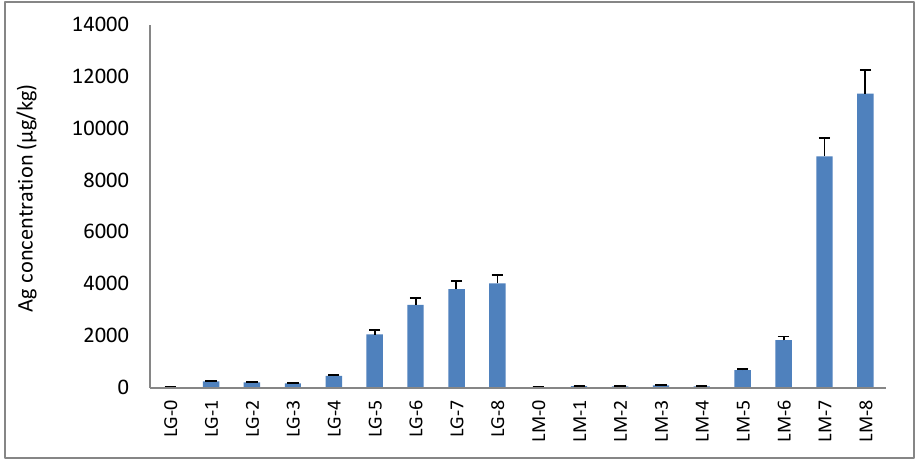
Figure 3. Ag accumulation ratios by L. gibba and L. minor . Despite the low concentrations of silver (9.25 µg L − 1 ) in the acid mineral water used in the study, L. gibba and L. minor were able to remove Ag from 433 L and 1222 L of acid mine water, respectively, by the end of the 8-day experiment. During the first four days of the experiment, similar increases in Au accumulation were observed in both L. gibba and L. minor . From the fifth to the eighth day, both plants exhibited a linear and very high accumulation performance. According to the control samples, L. gibba accumulated 78 times (176 µg kg − 1 ) and 394 times more Au (884 µg kg − 1 ) from acid mine water on day 5 and day 8. Similarly, L. minor accumulated gold from acid mine water 31 times (16.2 µ g kg − 1 ) and 336 times on the fifth and eighth days, respectively, (882 µ g kg − 1 ) compared to the control sample (Figure 4). Despite the low concentration of gold in the acid mineral water used in the study (0.92 µg L − 1 ), L. gibba and L. minor removed Au from 958 L and 956 L of water, respec- tively, by the end of the 8-day experiment.